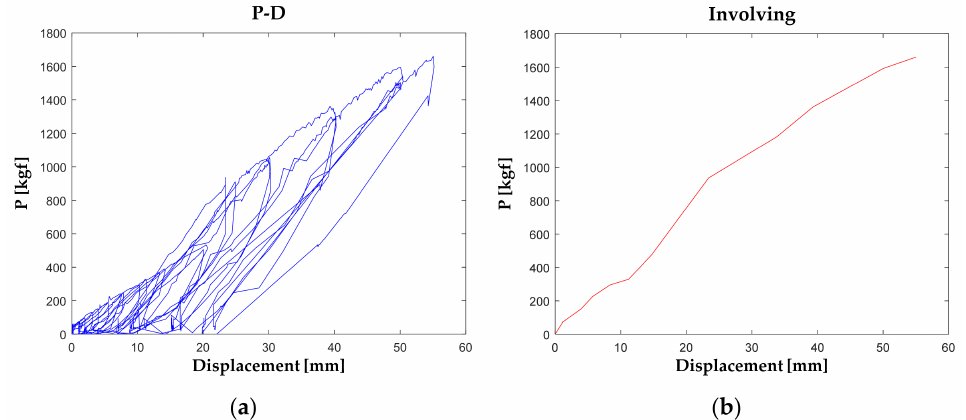
Figure 22. Cyclic response: ( a ) Load-displacement relationships on the different load cycles; ( b ) In- volving curves of load displacement.